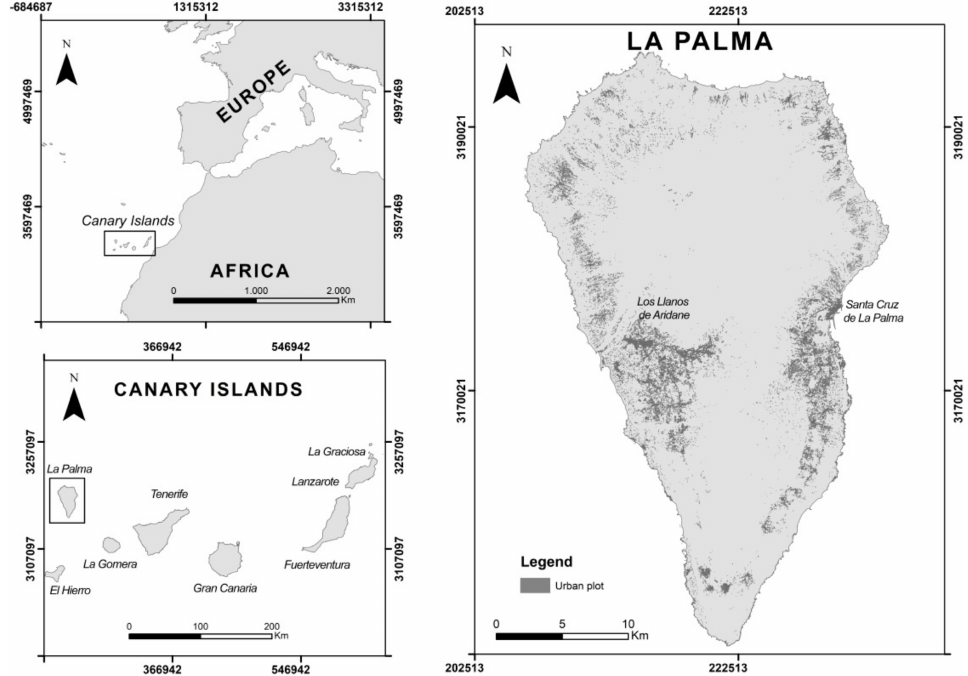
Figure 2. Location of Santa Cruz de La Palma and Los Llanos de Aridane cities, Canary, Spain. Source: Grafcan.